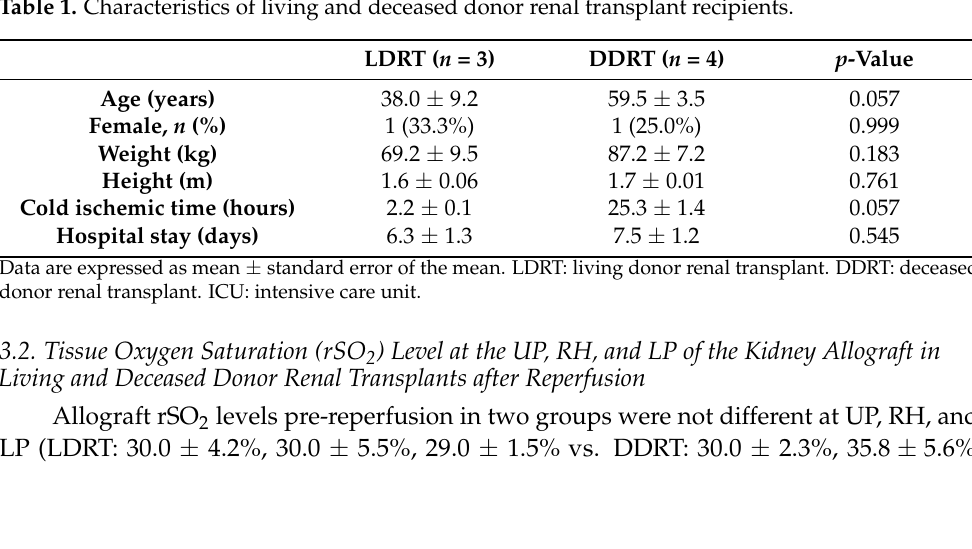
Table 1. Characteristics of living and deceased donor renal transplant